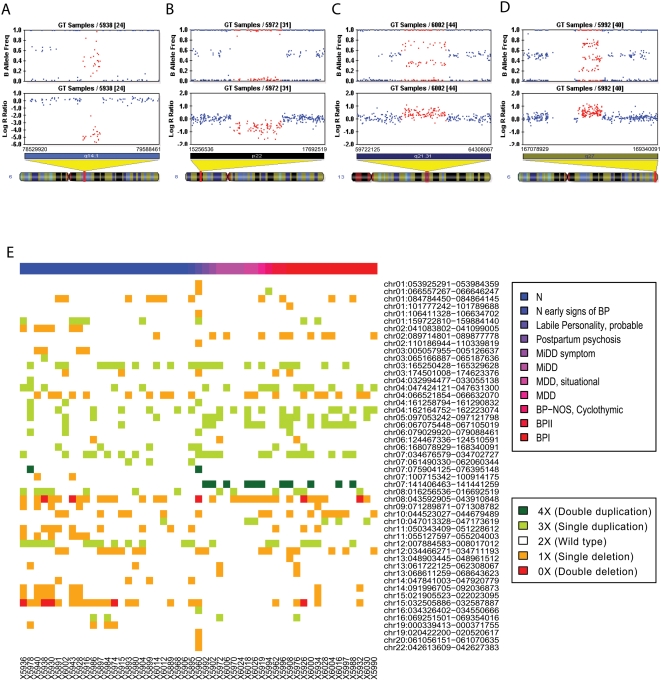
Characteristic signal patterns of copy number states and the distribution of CNVs in family 884.(A–D) Visualization of signal intensity for the CNV regions with 0 copy (A), 1 copy (B), 3 copies (C) and 4 copies (D) in the Illumina BeadStudio software. For each SNP, the Log R Ratio (LRR) is a normalized measure of signal intensity for two alleles of a SNP, while the B Allele Frequency (BAF) is a normalized measure of the allelic intensity ratio of the two alleles. Different copy number states have characteristic patterns of LRR and BAF. (E) Visualization of the CNVs by heatmap. CNVs are ordered by chromosomes then by chromosomal positions by the NCBI Release 36 Human Genome. Clinical status for all subjects is indicated by color; the respective hierarchical clustering was then computed for each group.